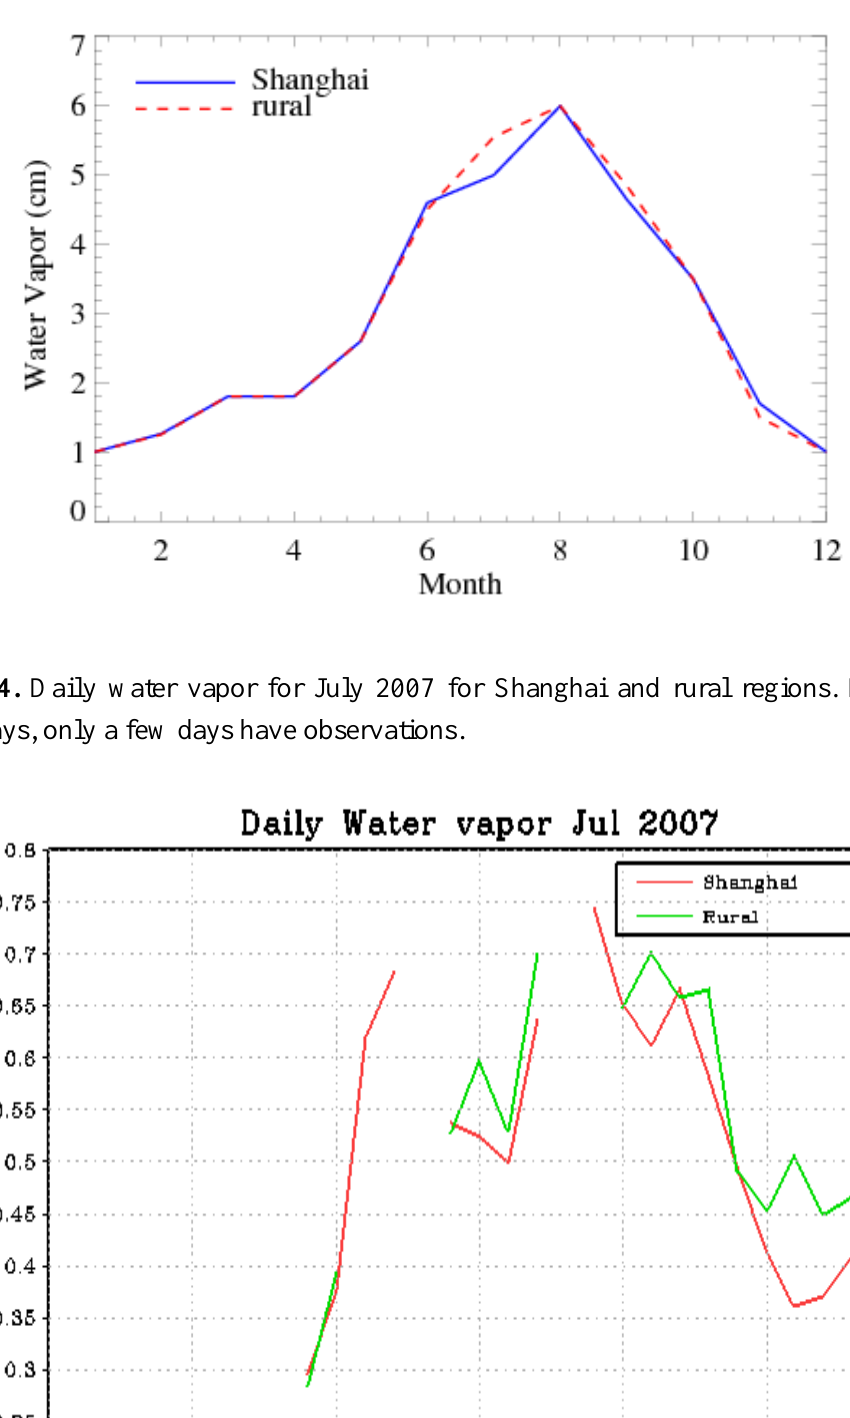
Figure 13. Muti-year averaged (2000–2008) water vapor for Shanghai and rural regions. Data is from monthly MODIS observations at 10:30 AM.